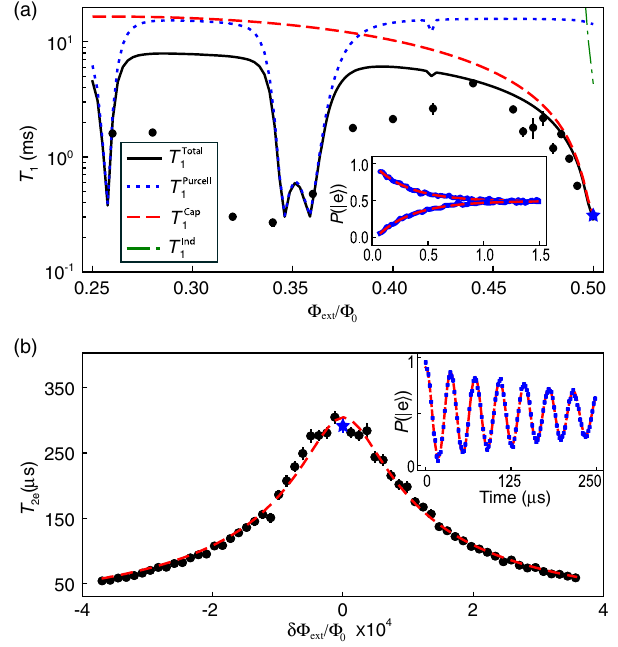
FIG. 3. Qubit coherence as a function of the flux. (a) Energy relaxation time ( T 1 ) as a function of the external flux, denoted by black circles. The lines represent theoretical limits set by dielectric ( T cap 1 ), inductive ( T ind 1 ), Purcell ( T Purcell 1 ), and the combined loss ( T total 1 ). The inset shows the decay of P ðj e iÞ to 0.495 after preparing the qubit in j g i , j e i at the flux-frustration point ( ⋆ ). (b) Echo decay time T 2 as a function of the flux near e the flux-frustration point. The inset shows an echo measurement at the flux-frustration point ( ⋆